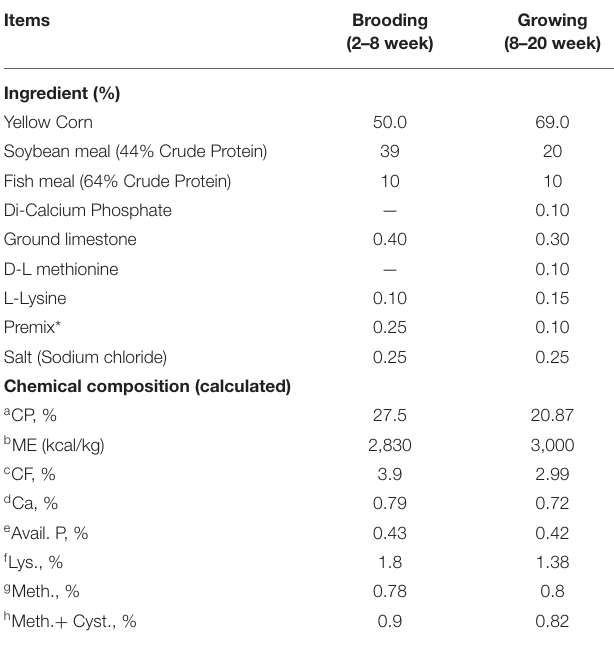
TABLE 1 | Ingredients and the composition of brooding and growing diets (%, as- fed